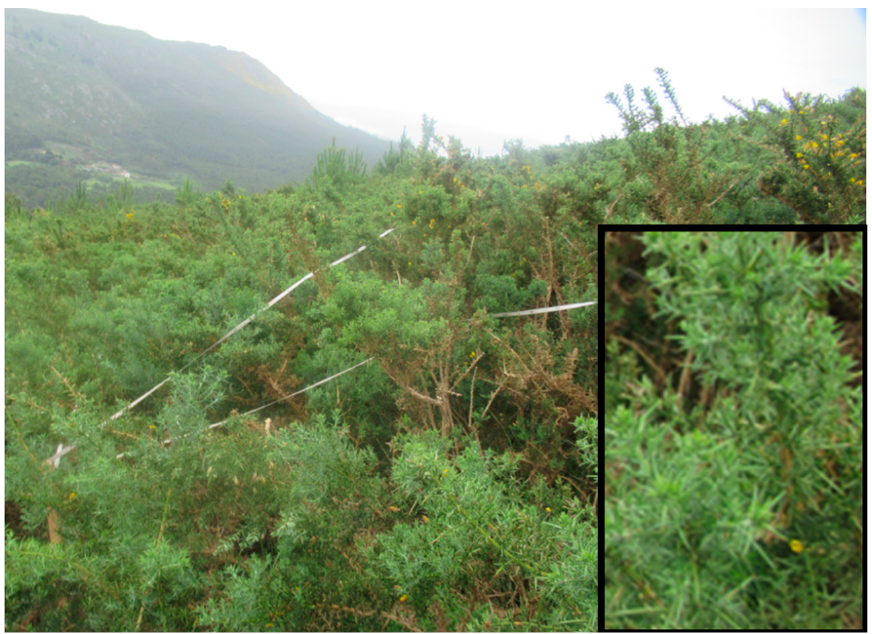
Figure 2. Partial view of a sampling plot six years after a fire.